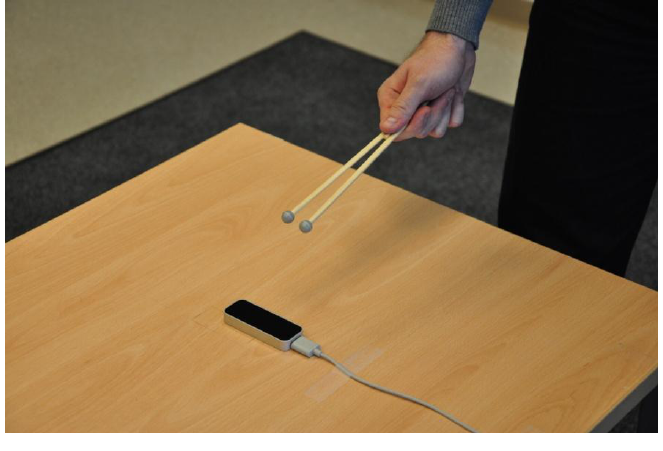
Figure 4. The V-tool used for dynamic